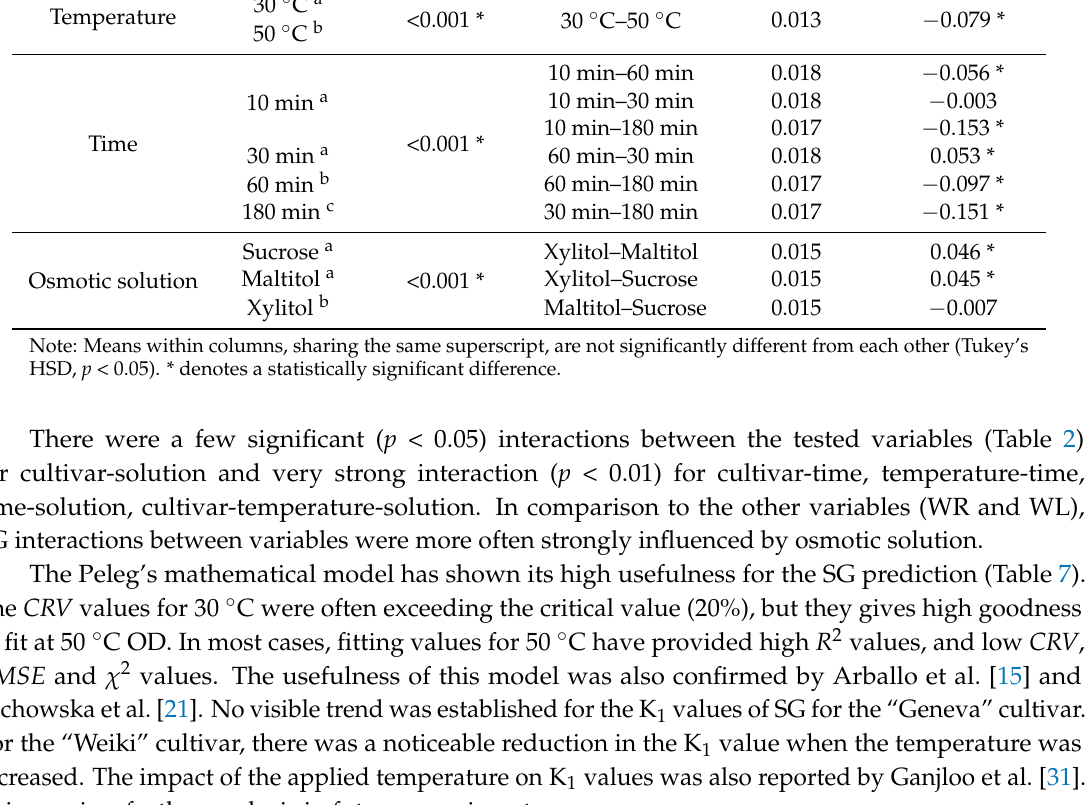
Table 6. The influence of osmotic pre-treatment in different solutions, and time on SG [g/g i.d.m.]. Factor p -Value Contrast +/ − Limits Difference Geneva a <0.001 * Geneva–Weiki 0.013 − 0.201 * Cultivar Weiki b 30 ◦ C a Temperature <0.001 *